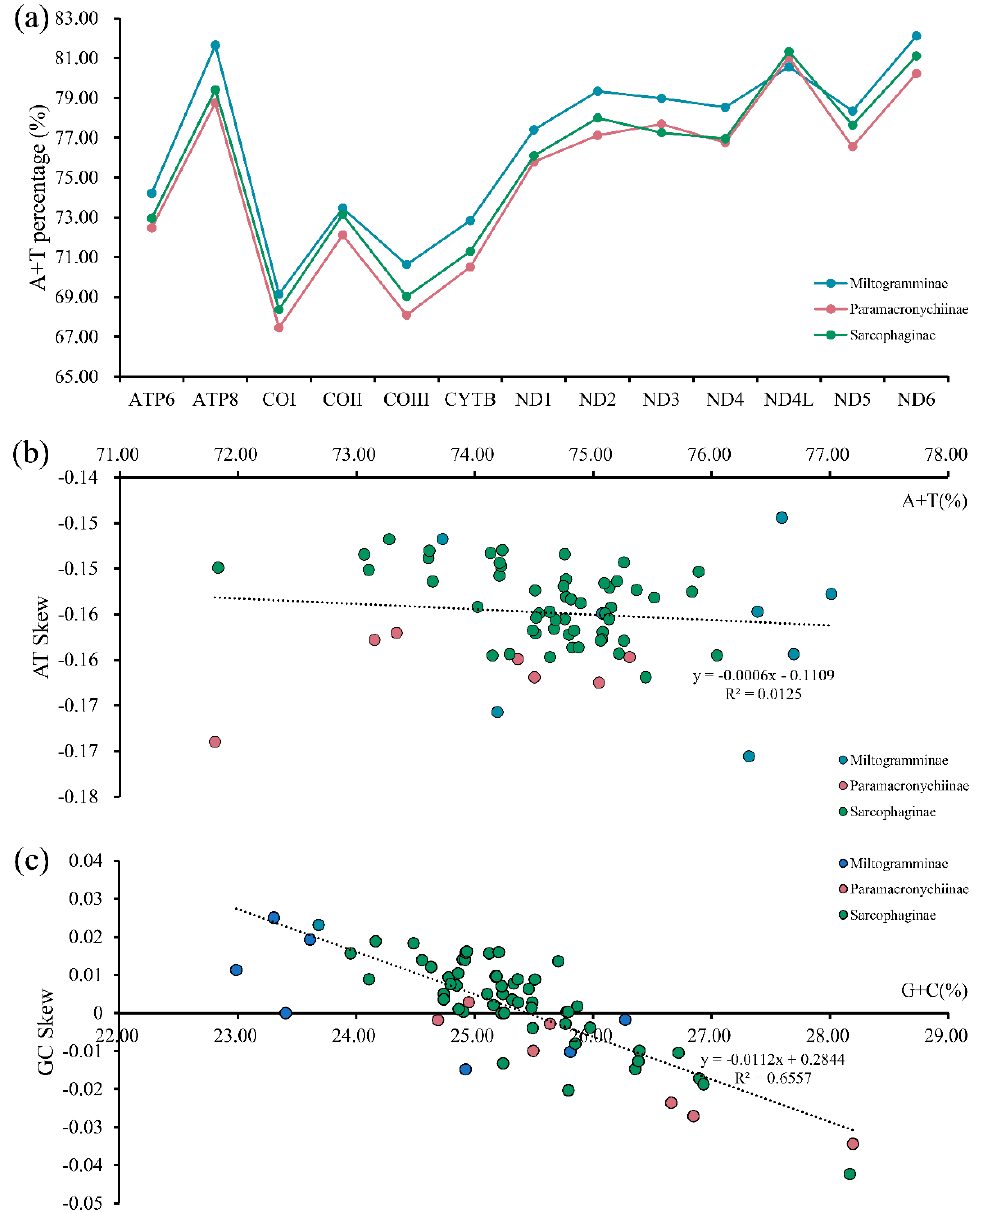
Figure 2. Nucleotide composition analysis of mitochondrial genomes from three subfamilies of Sarcophagidae: A + T percentage of the 13 protein-coding genes ( a ) and the corrections between A + T% vs. AT skew ( b ) and G + C% vs. GC skew ( c ) in the 13 protein-coding genes.